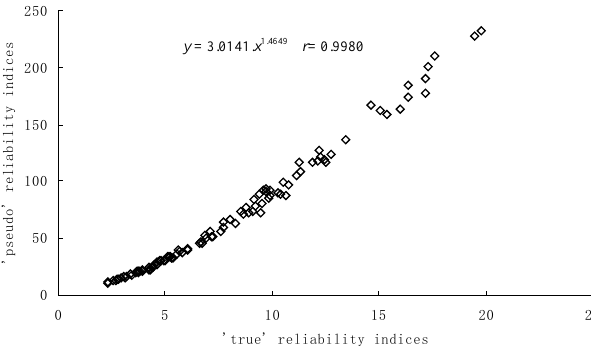
Table 4. Mean values and standard deviations for soil property pa- rameters (soil number from top to bottom).